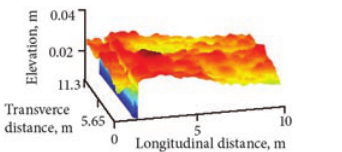
Fig. 3. Example of randomly generated class B road profile carpet combined with 2 cm